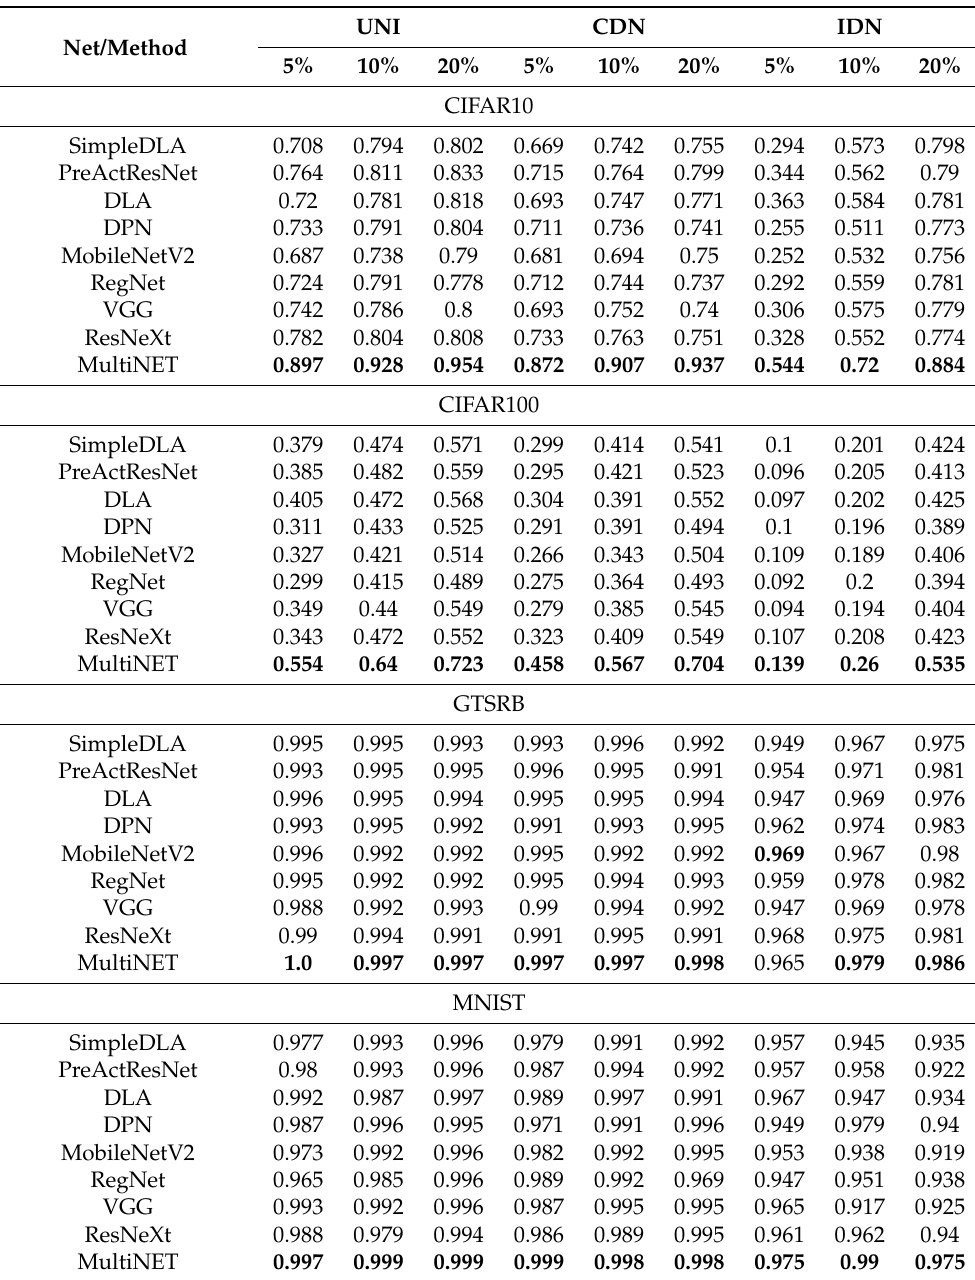
Table 3. Area under precision–recall curve (AUC) measure of noisy label detection efficiency. Best results are indicated in